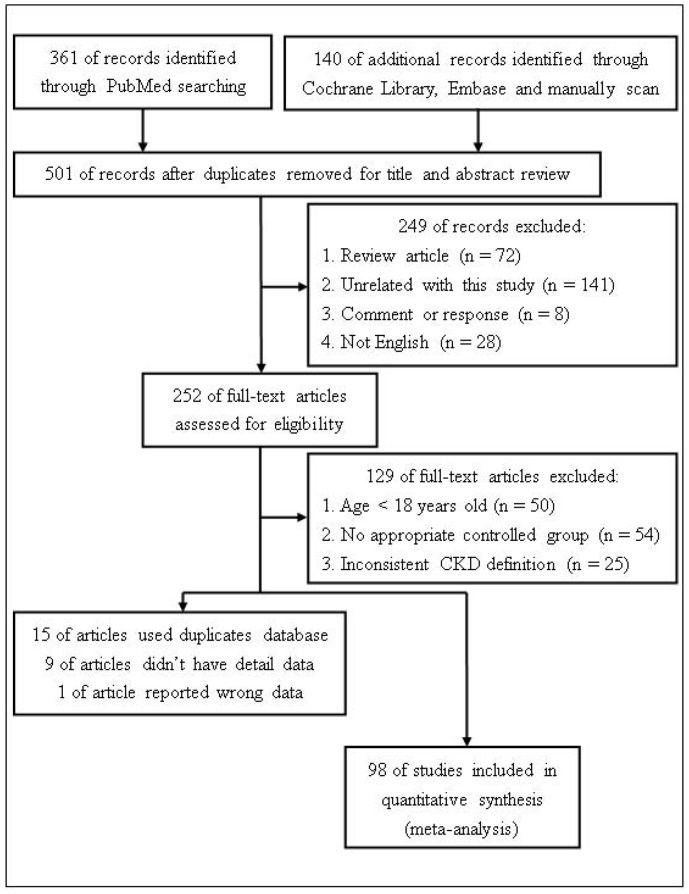
Flow diagram of identification process for eligible studies in this study.n: number of studies were deleted for aforementioned reasons.